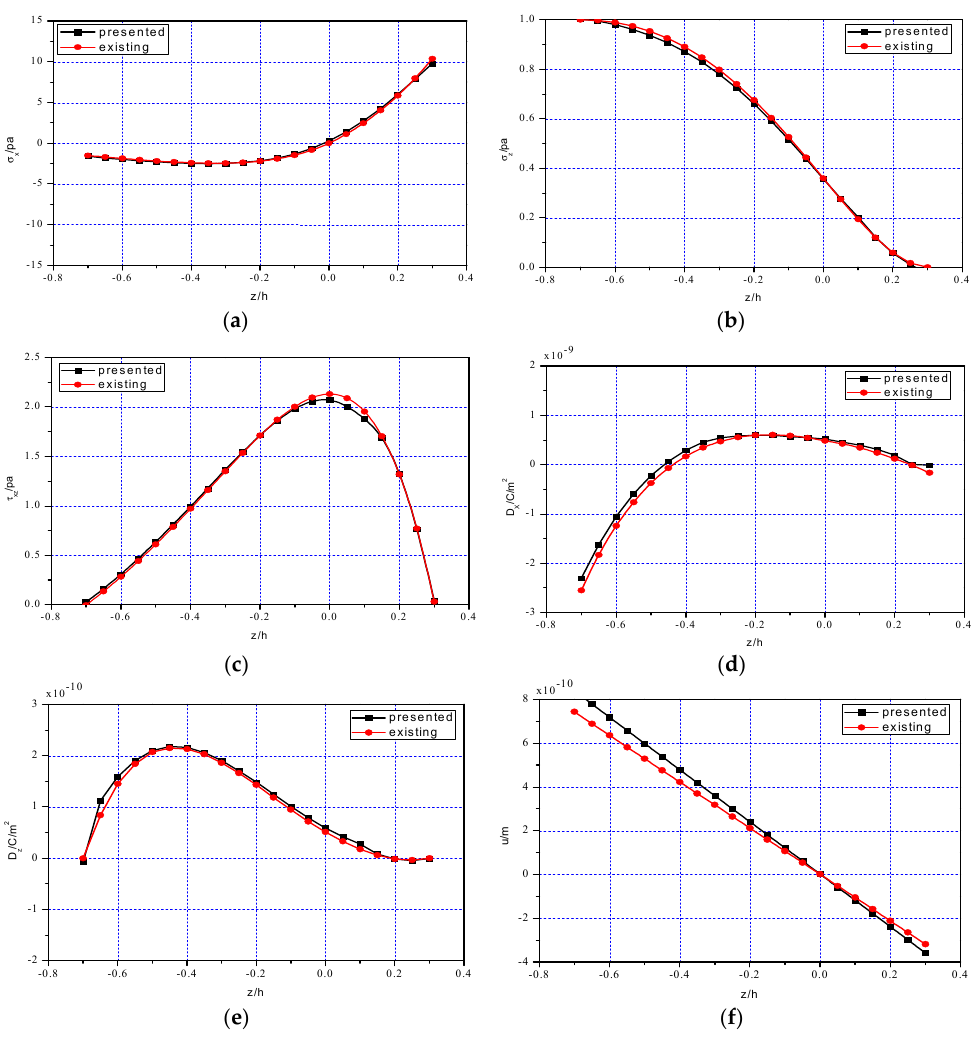
Figure 8. Comparisons of two-dimensional simulation presented in this study and existing solution from He et al. [27] at x = 0.25 l : ( a ) Stress σ x ; ( b ) Stress σ z ; ( c ) Stress τ xz ; ( d ) Electrical displacement D x ; ( e ) Electric displacement D z ; ( f ) Mechanical displacement u